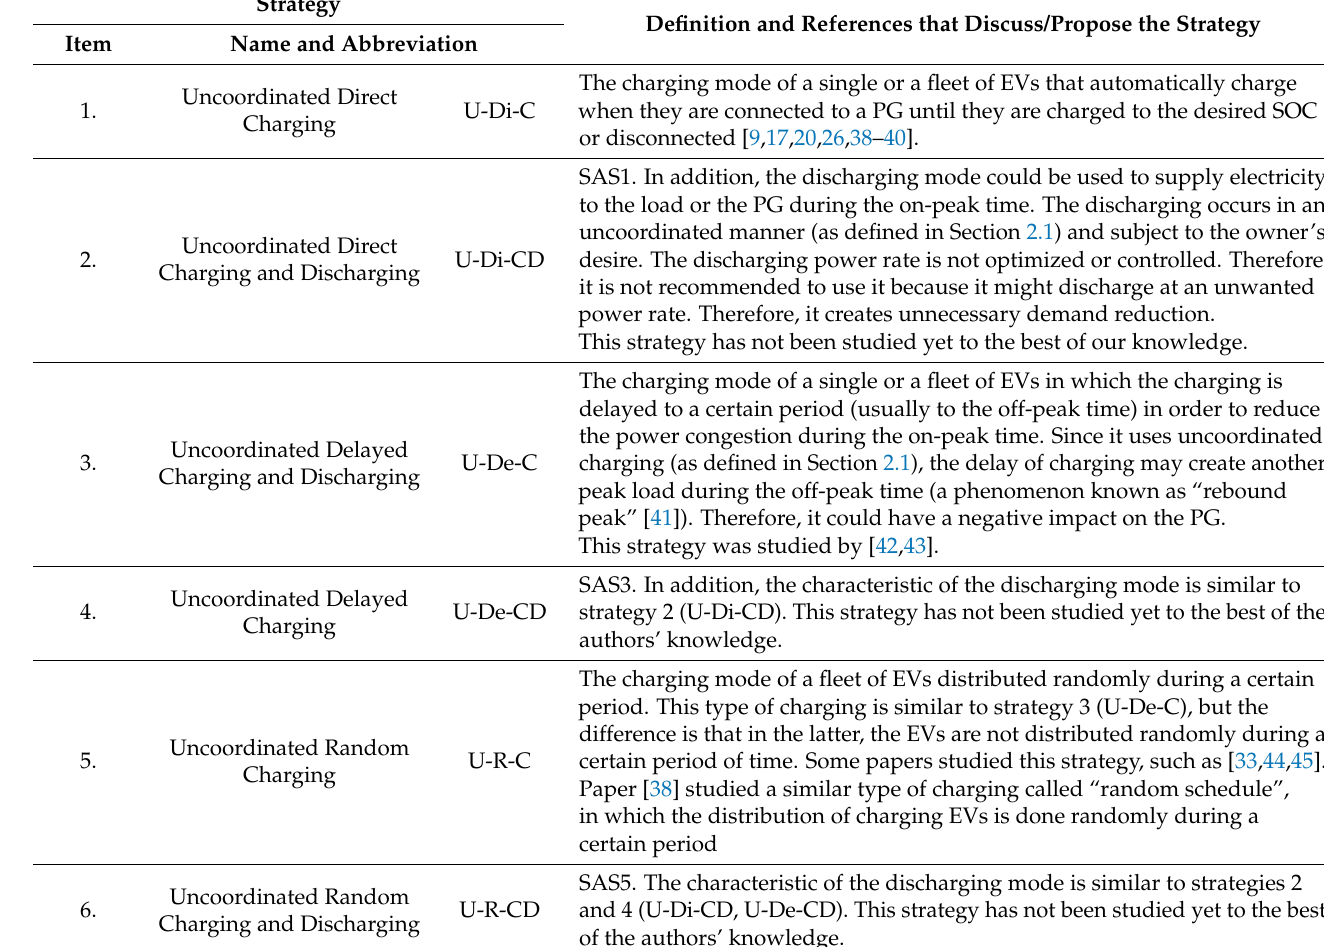
Table 1. Definitions of Uncoordinated Charging Strategies of Electric Vehicles (EVs).